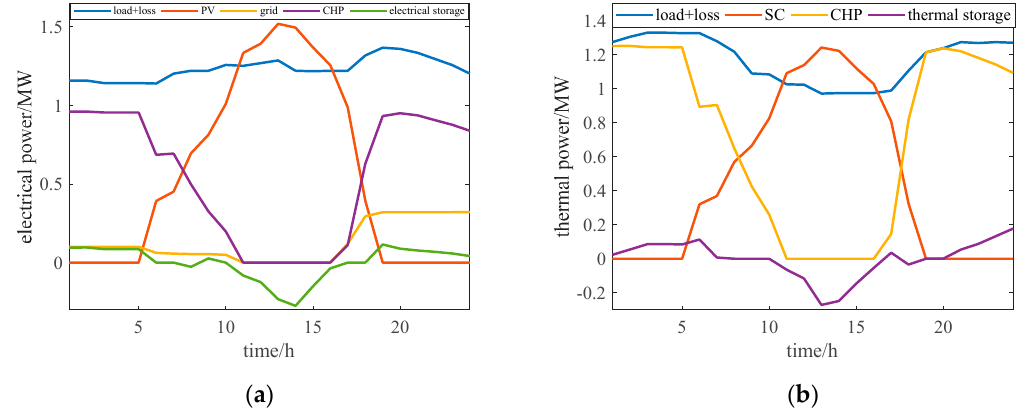
Figure 10. ( a ) Electrical power output in Case 2.5; ( b ) thermal power output in Case 2.5.